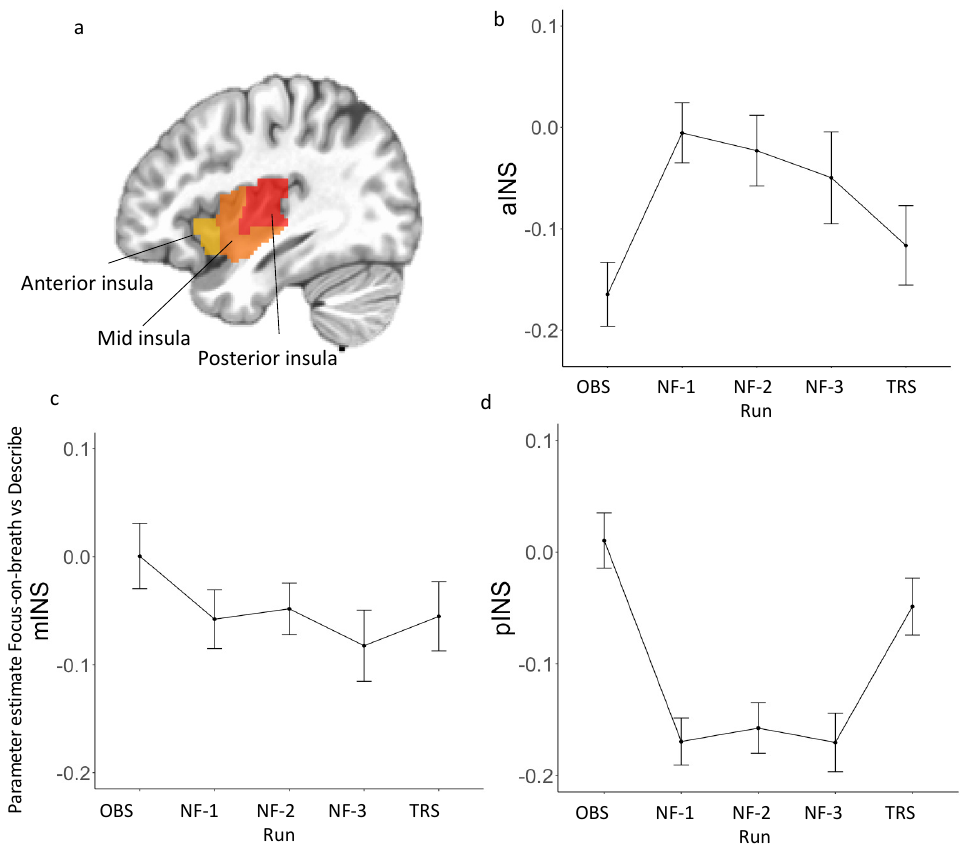
Figure 2. ( a ) Three insular cortex regions of interest (ROIs) extracted from the Brainnetome Atlas. ( b – d ) Parameter estimate (Focus-on-Breath vs. Describe) across each run in each insula subregion. See Appendix B Table A2 for peak coordinates for each insula subregion. Abbreviations: OBS, Observe; NF, Neurofeedback; TRS, Transfer.